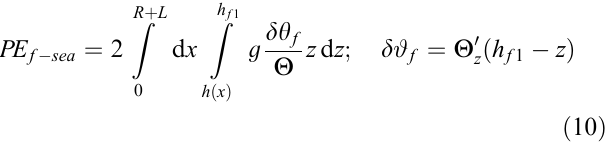
adiabatic redistribution so that h m < h f 1 . h f 1 and h f 2 represent the final heights of the boundary layer h 1 and h 2 , respectively. R and L as in Fig. 3a. c As in a but for a high mountain. d As in b but for h m > h f 1 , for a